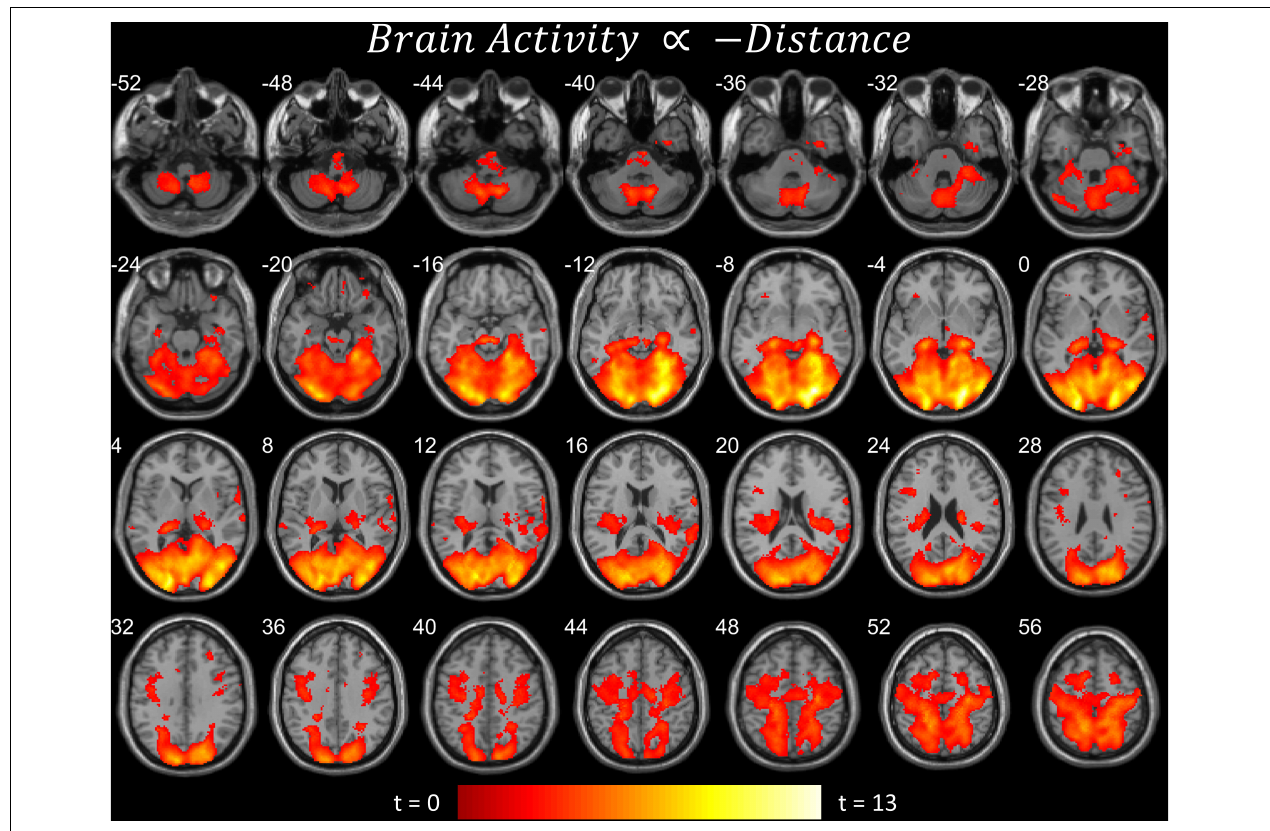
FIGURE 3 | Brain areas that become more active when near the target. Significant parametric modulation (pFDR < 0.05 peak level corrected across entire brain) rendered on anatomical MRI slices using xjView toolbox (https://www.alivelearn.net/xjview). Note widespread, distributed activity, particularly in cerebellum and